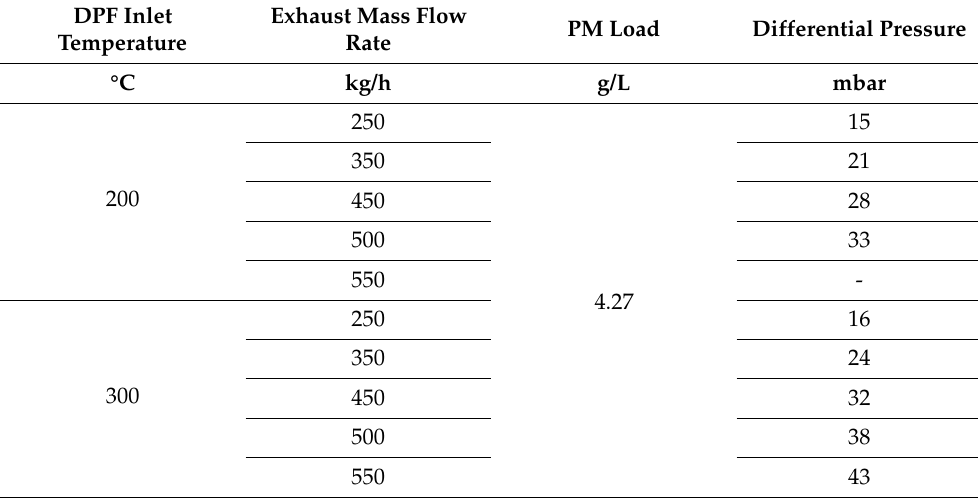
Table 4. Result of differential pressure for PM load of 4.27 g/L.